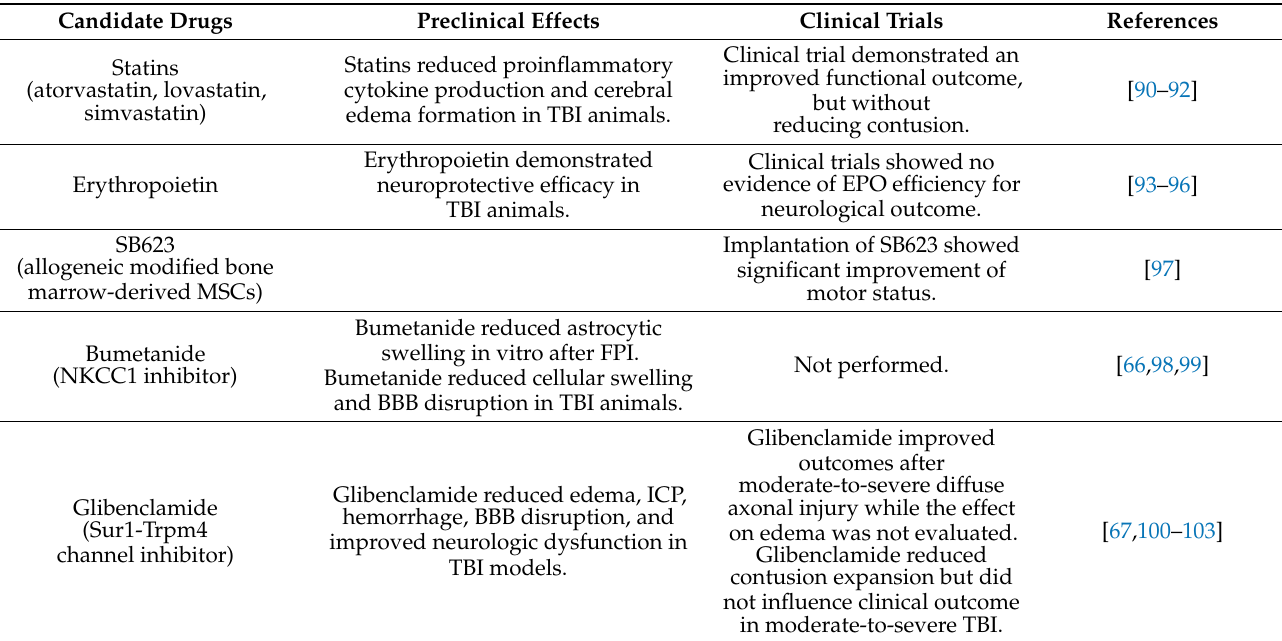
Table 3. Summary of the candidate drugs for